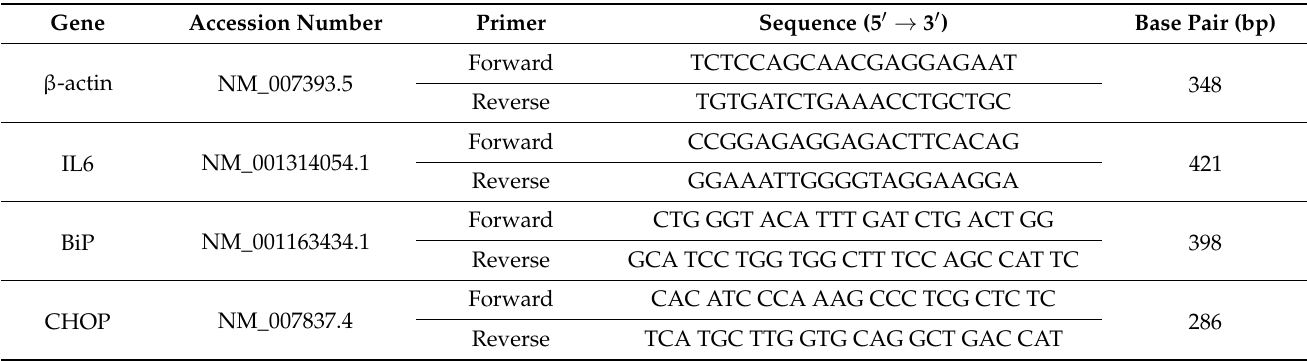
Table 2. Reverse transcription PCR primer sequences